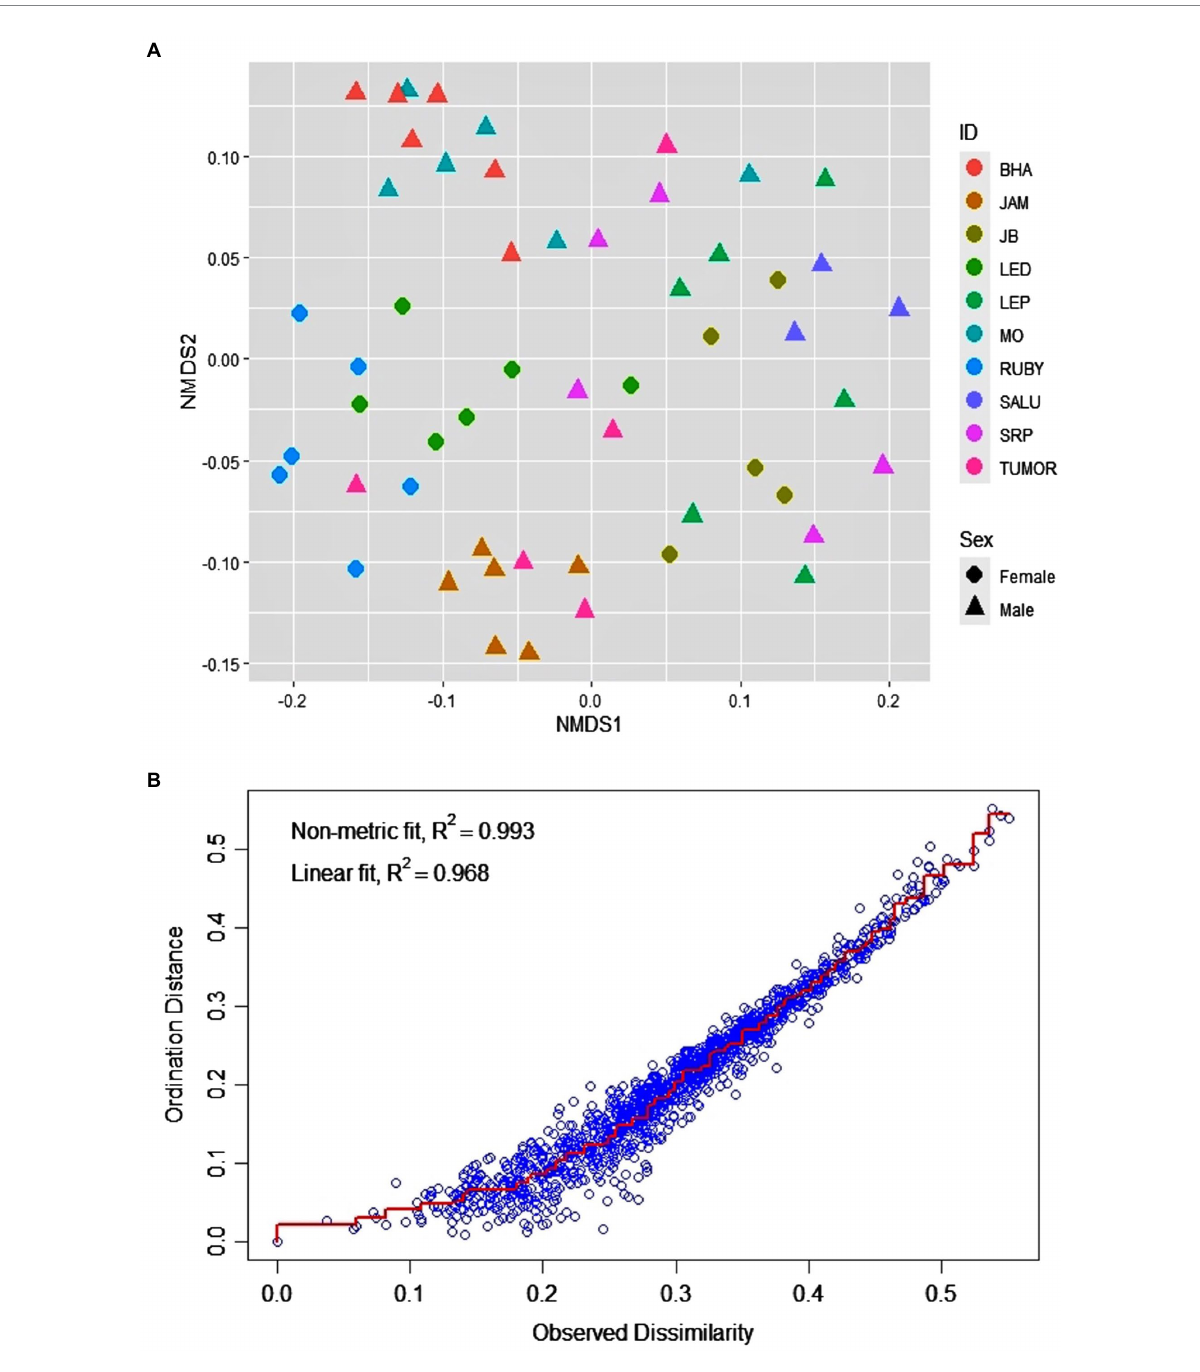
FIGURE 3 Distribution of the 60 events of bottle-directed manipulative techniques, displayed by the 10 study bonnet macaques of the DV group during Task II, as analyzed by two-dimensional Non-metric Multi-Dimensional Scaling (NMDS), using the Jaccard similarity measure. (A). Individual macaques are indicated by different colors and the two sexes by different shapes: female – circle, male – triangle. (B). Stress-plot of the NMDS model. Stress = 0.08, non-metric R 2 =